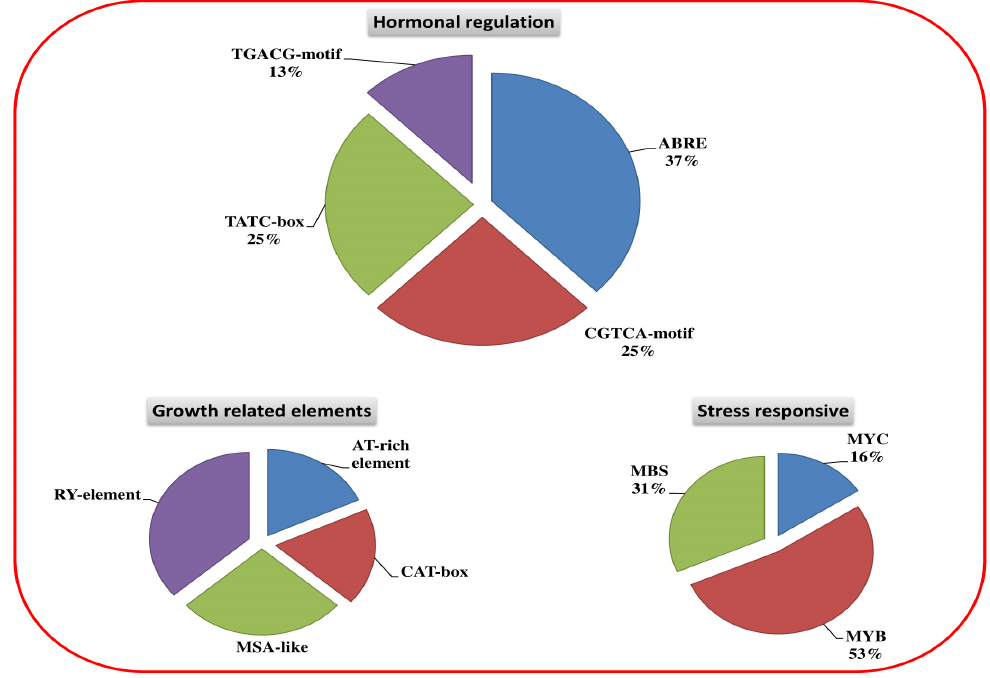
Figure 5. Cis- acting elements presented in the 1.5 kb upstream regions of OsHKT genes. The figure shows hormonal, stress, and growth responsive cis -regulatory elements of the OsHKT gene family in